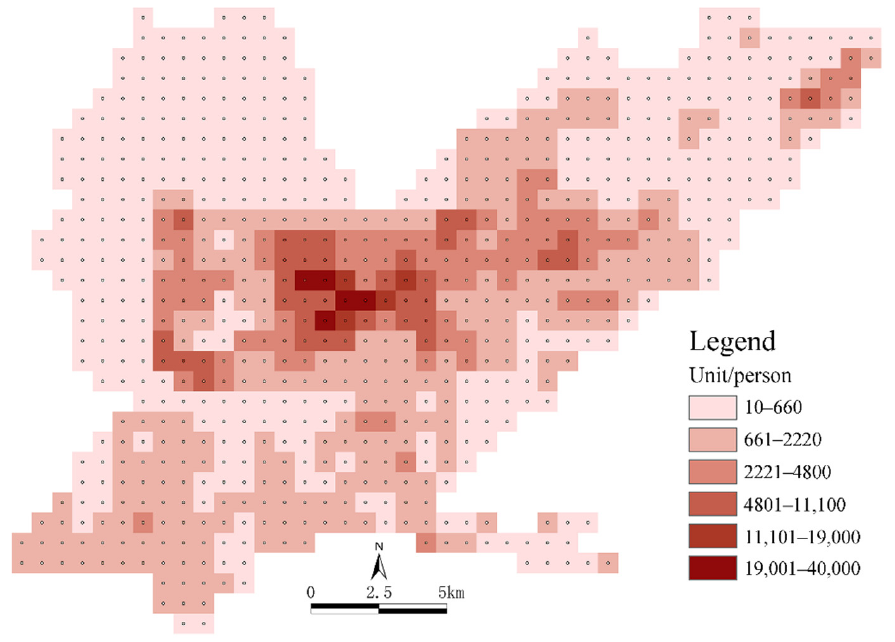
Figure 3. The population density of a 1 km × 1 km grid in the main urban area in Jiaozuo. Table 2. Basic information on the study data from 2020.